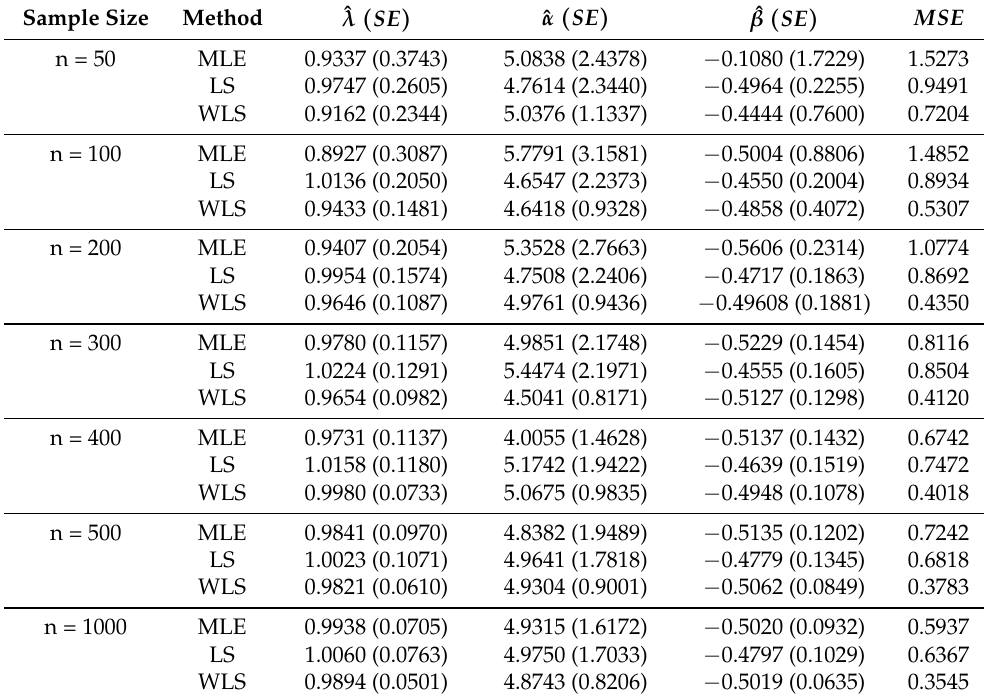
Table 1. λ = 1, α = 5, β = − 0.5.